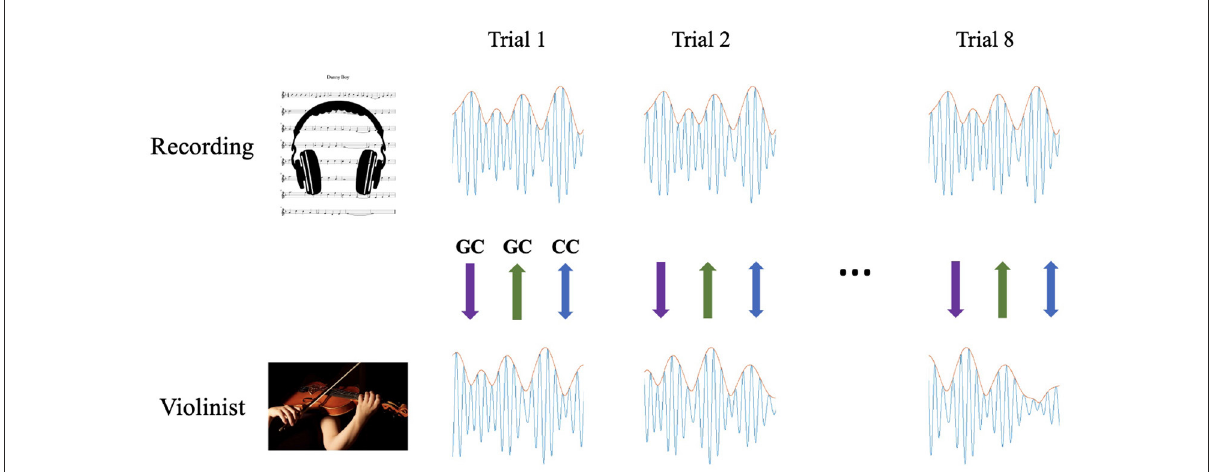
FIGURE1 Experimental design and procedure. The violinists listened to the recordings through headphones while looking at the sheet music (top) and recorded themselves playing along with them (bottom) across eight successive trials. We then calculated Granger causality in both directions (from the recordings to the performances, shown in purple, and from the performances to the recordings, shown in green) and cross-correlation (for similarity and for synchrony, shown in blue) for each trial